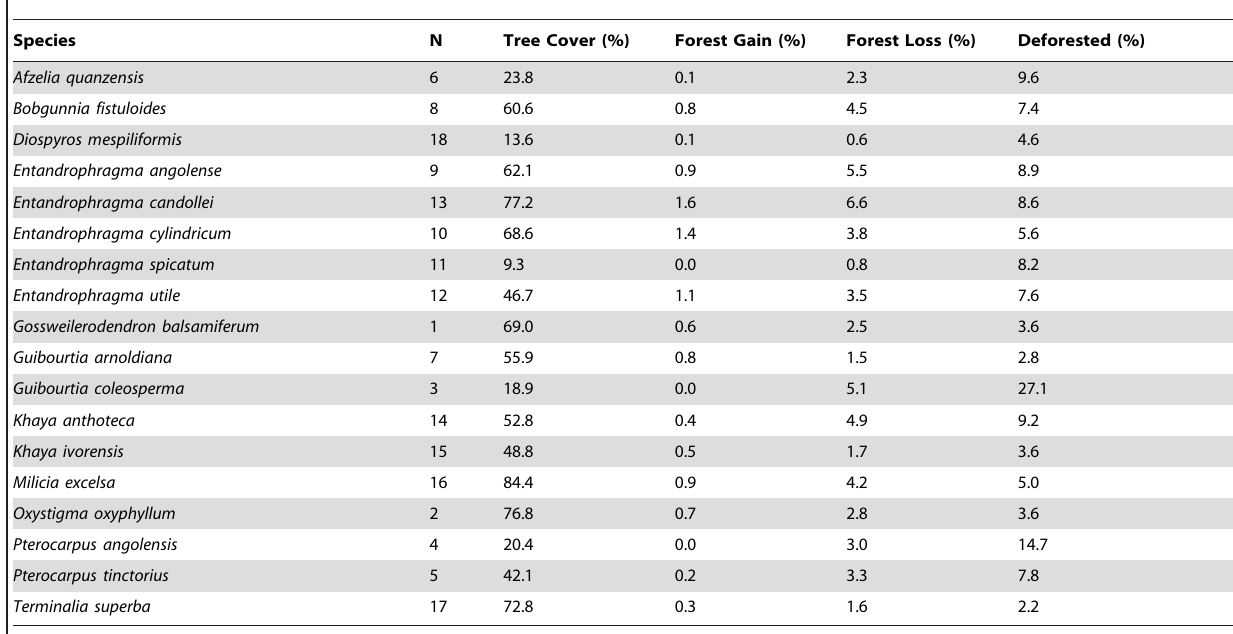
Table 3. Forest cover (in 2000) and forest cover changes (2000–2012) estimated in 5-km buffers around the herbarium collection localities for each Angolan timber tree